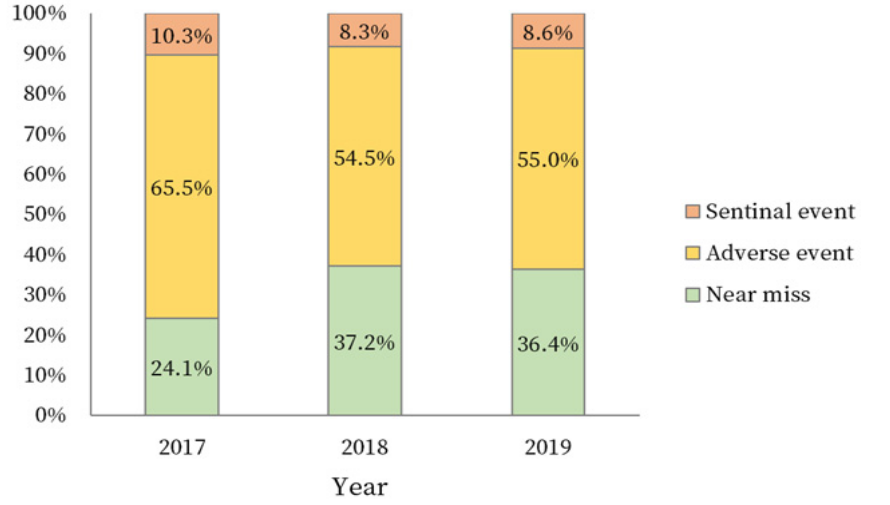
Figure 1. Three-year trend by severity of PSIs.